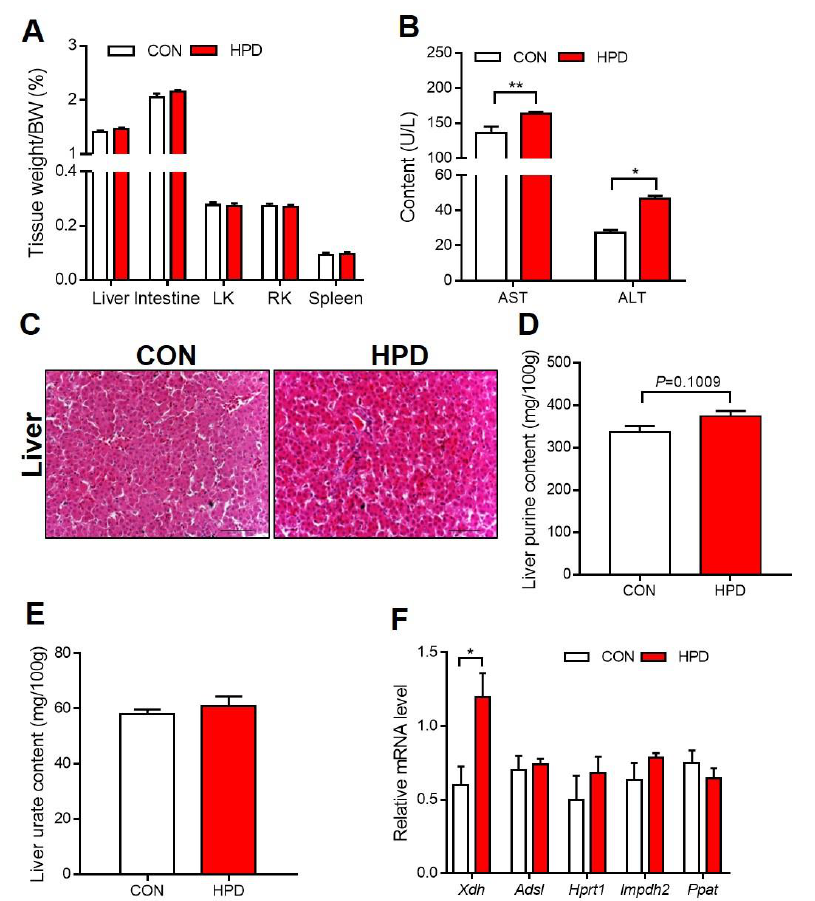
Figure 6. HPD increases the production of urate in the liver. ( A ) Liver, intestine, left kidney (LK), right kidney (RK), and spleen relative weight. ( B ) Serum AST and ALT content. ( C ) H&E staining of liver (scale: 50 µ m). ( D ) Liver total purine content, including adenine, guanine, hypoxanthine, and xanthine. ( E ) Liver urate content. ( F ) The expression of urate-producing-related genes including Xdh , Adsl , Hprt1 , Impdh2, and Ppat in the liver. Values are presented as the mean ± SEM. Di ff erences were assessed by non-parametric t test followed by Mann–Whitney test and denoted as follows: * p < 0.05 and ** p < 0.01 compared with